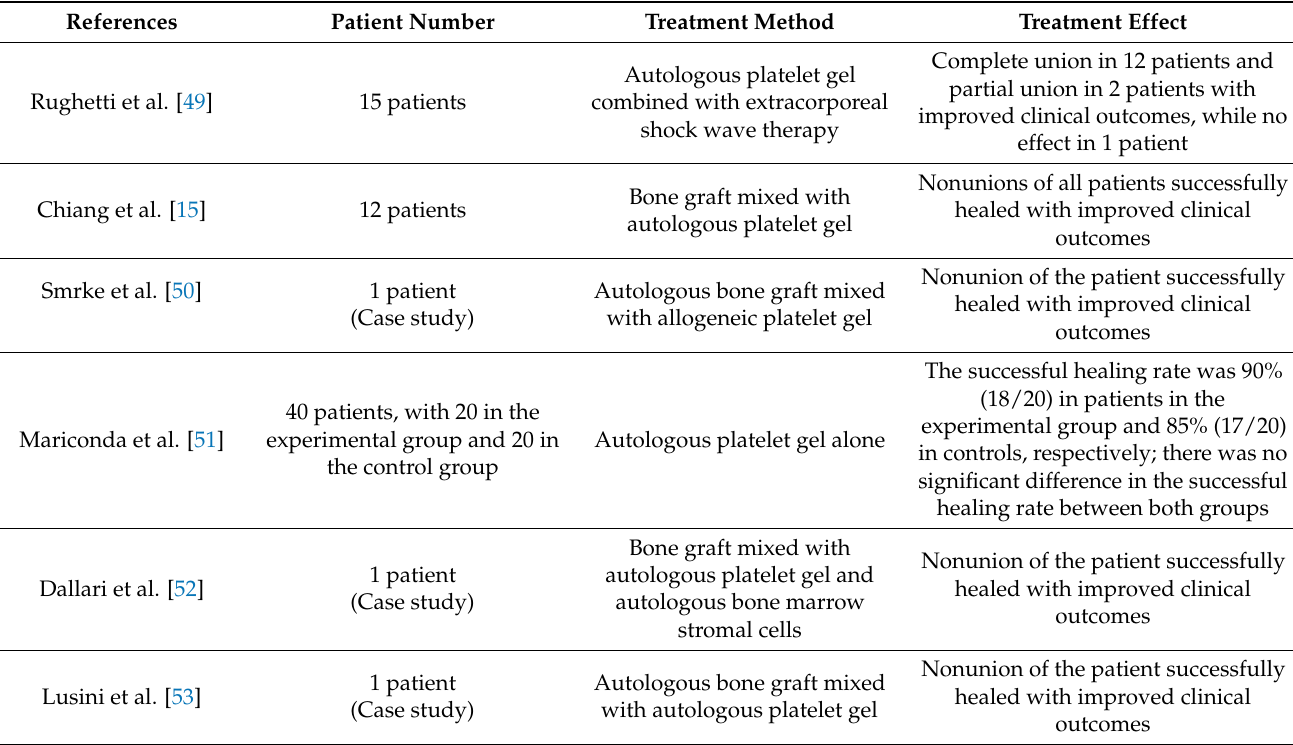
Table 2. Summary of the patient number, treatment method, and effect of each reviewed